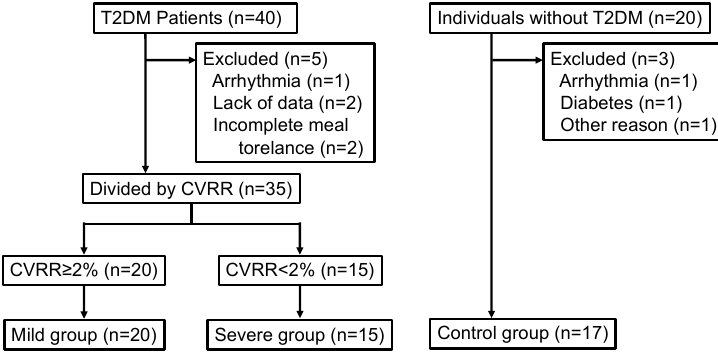
Figure 2. Participant flow. Abbreviations: T2DM, type 2 diabetes mellitus; CVRR, coefficient of variation of R-R